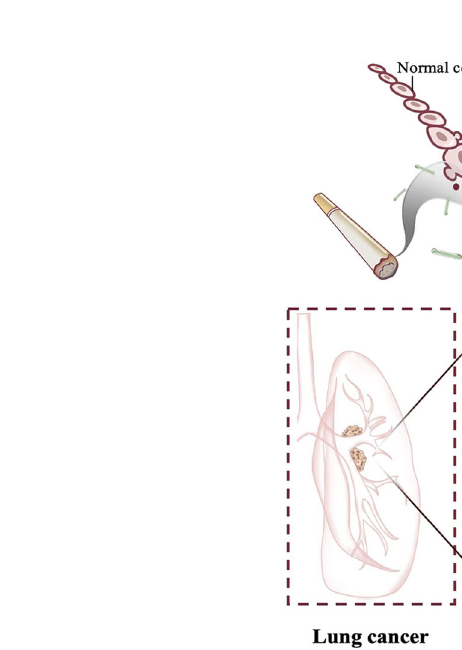
FIGURE 2 Changes in immune microenvironment of lung cancer caused by chronic in fl ammation. The long-term presence of carcinogenic factors such as smoking and pathogens causes lung cancer and shapes the tumor immune microenvironment. Around the tumor, in fl ammatory cells massively in fi ltrate and recruit cytokines and chemokines, which promote immune escape of the tumor through complex interactions. DC, Dendritic cell; TAM, Tumor macrophage; MDSC, Myeloid-derived suppressor cell; T cell, T lymphocyte cell; B cell, B lymphocyte